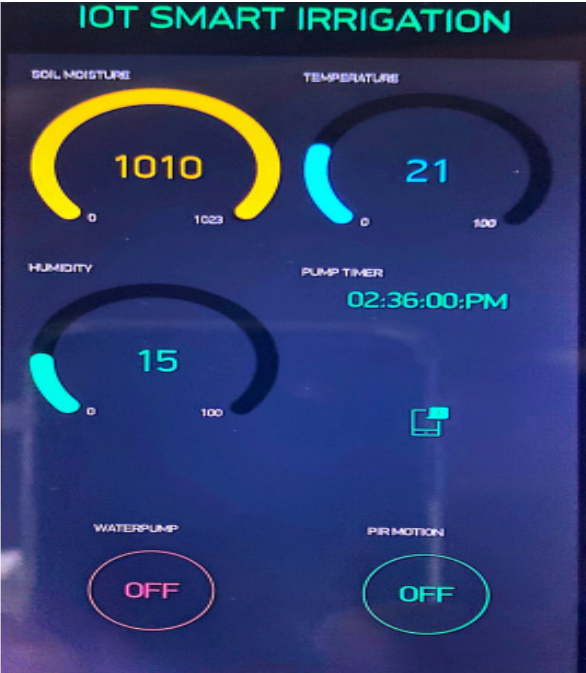
Figure 3. Dashboard display of the mobile device application.